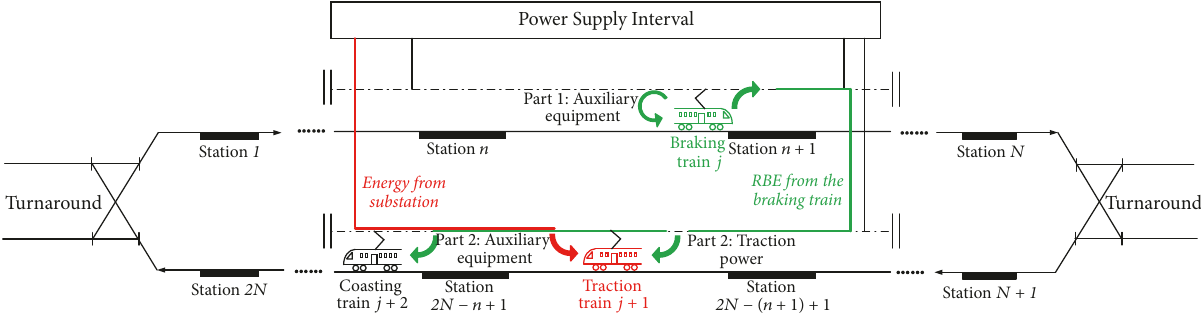
Figure 6: The utilization of regenerative braking